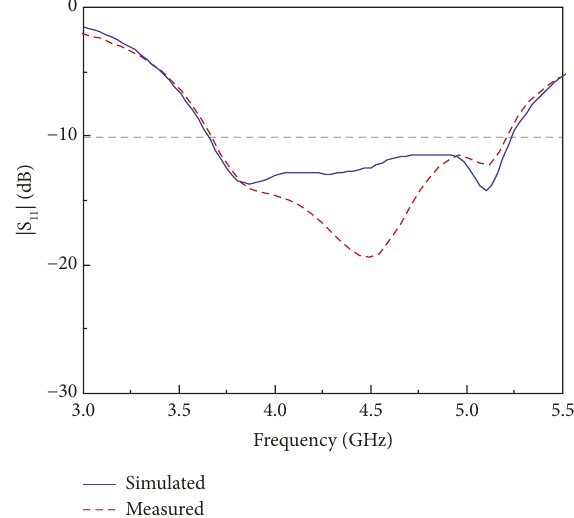
Figure 11: Simulated and measured reflection coefficient of the